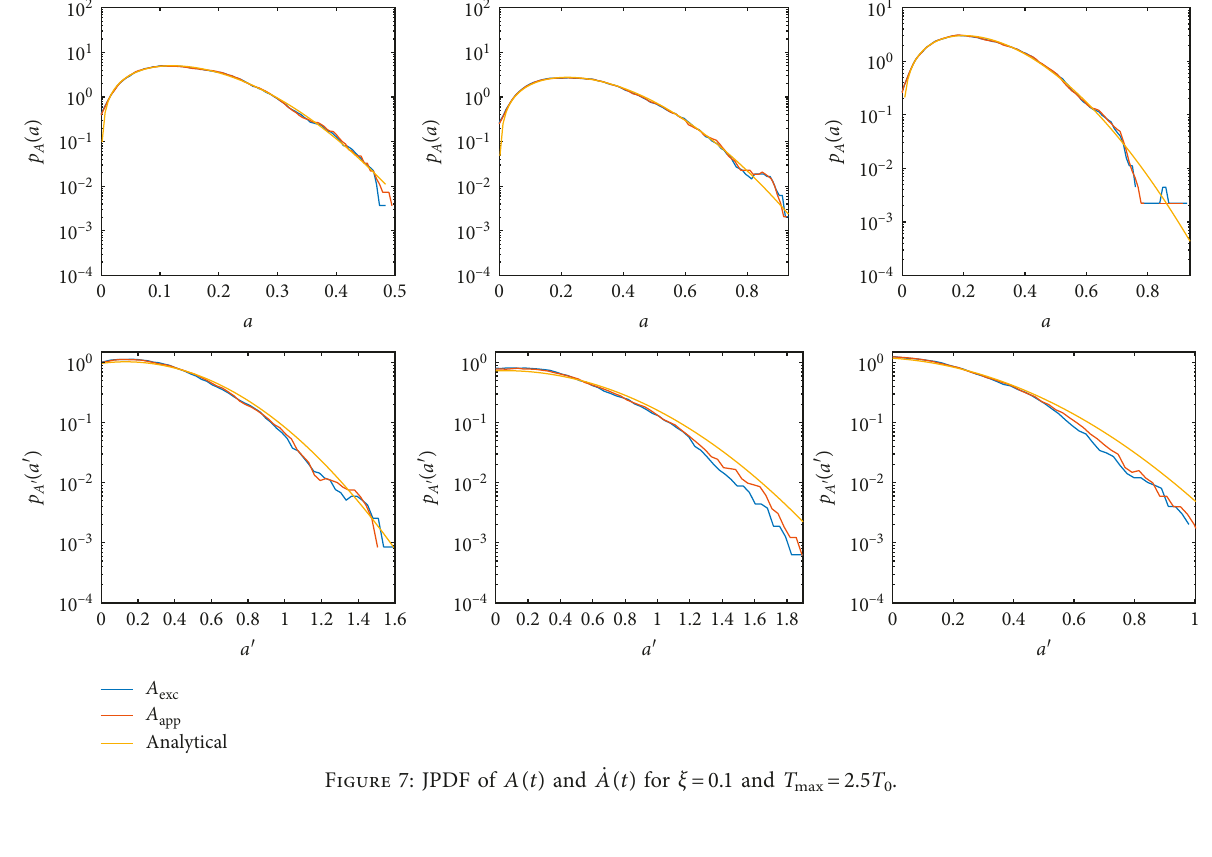
0.1 and T max (cid:31)